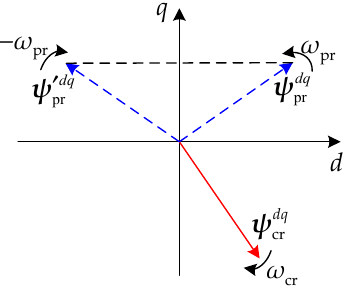
Figure 4. The relationship between the variables after the negative conjugate operation of the power machine variables.